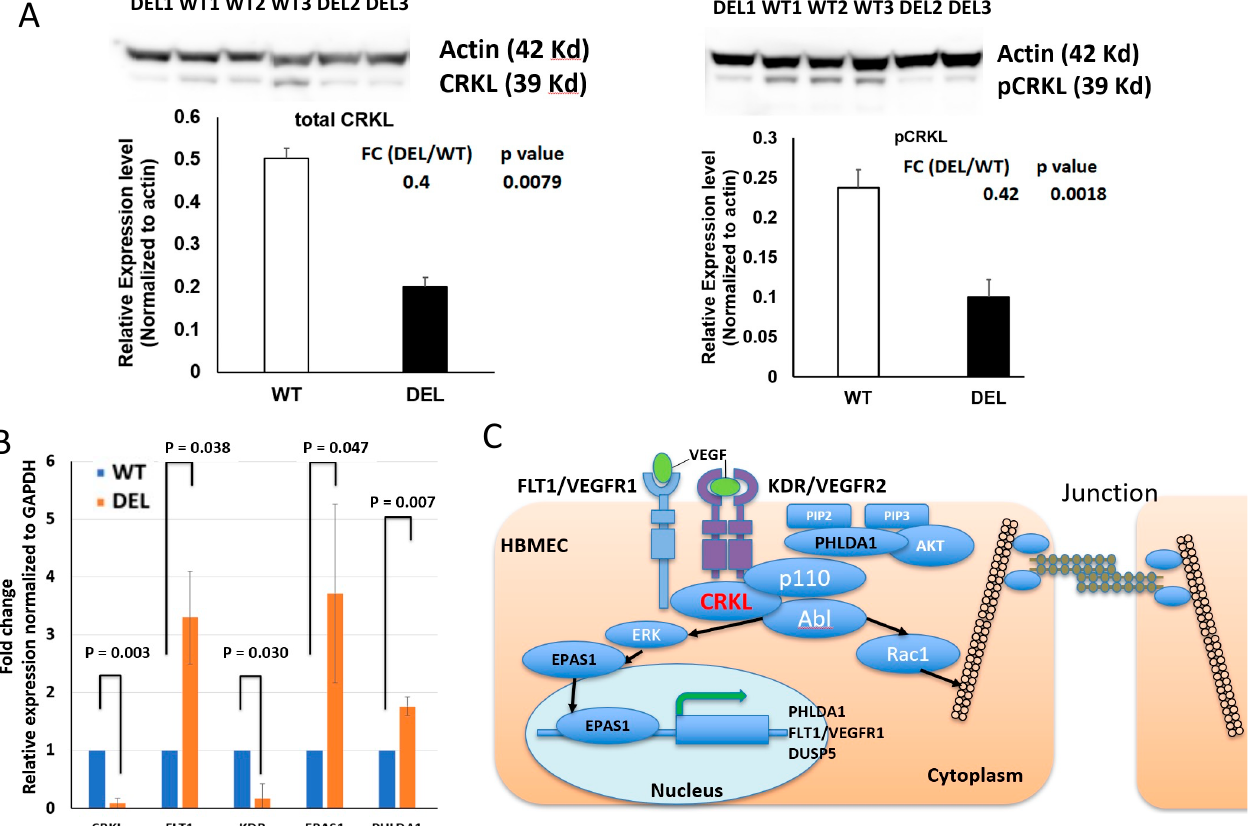
Figure 6. Involvement of CRKL and the VEGF signaling pathway. ( A ) Western blot confirmed decreased expressions of CRKL and pCRKL in 22q11.2DS-SCZ (Student’s t-test p = 0.0079 for total CRKL and p = 0.0018 for pCRKL). ( B ) RT-qPCR confirmed alterations in CRKL (Student’s t-test p = 0.003), VEGFR1/FLT1 ( p = 0.038), VEGFR2/KDR ( p = 0.03), EPAS1/HIF- 2a ( p = 0.047), and PHLDA1 ( p = 0.007) in 22q11.2DS-SCZ (sample size = 6, technical repeats = 5). ( C ). A working model of how alterations in CRKL-VEGF receptor interactions lead to deficits in the junction barriers. Ncase = 3, Ncontrol = 3, and error bar = standard deviation for all analyses.